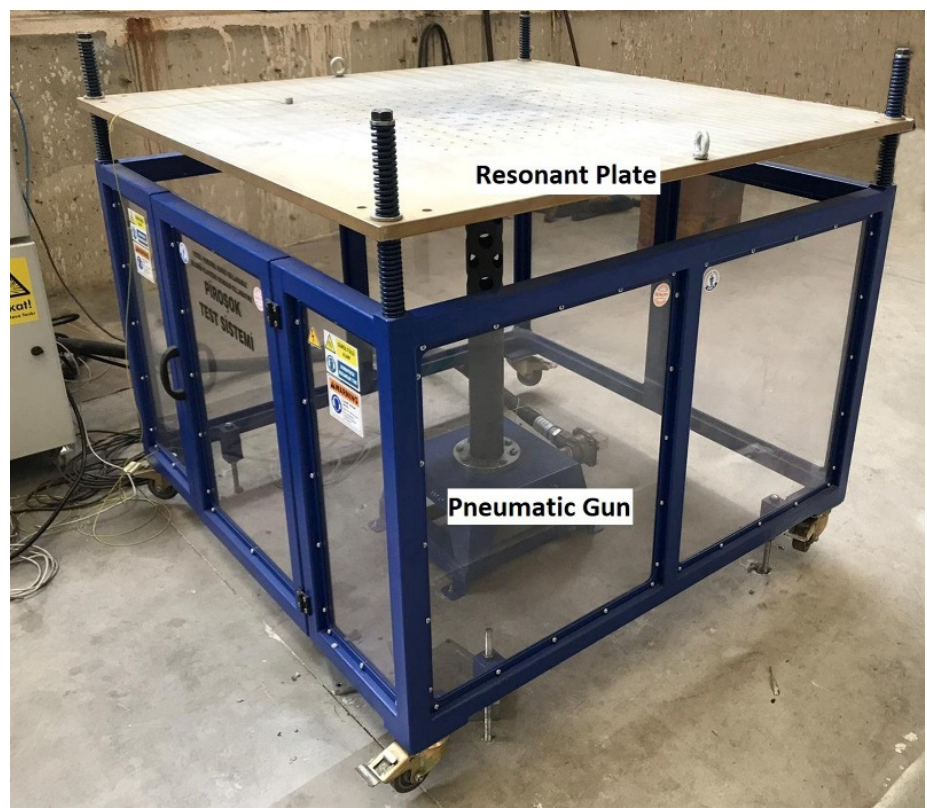
Figure 1. Main elements of the pyroshock test